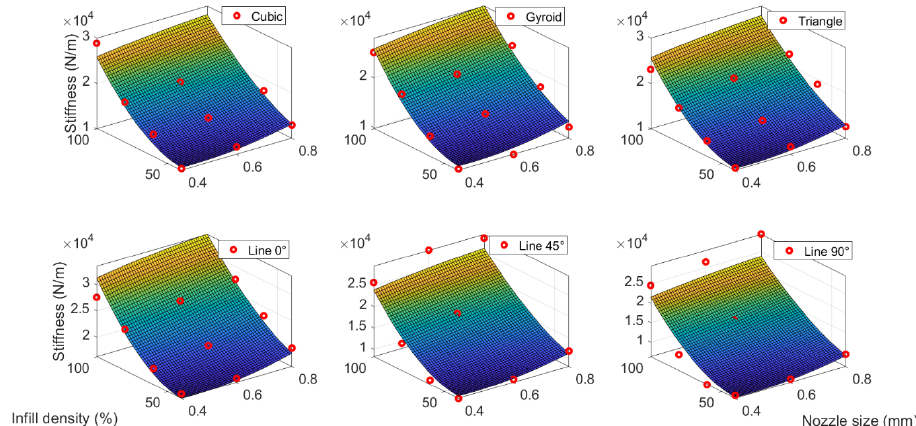
Figure 10. MLR correlation between process parameter and stiffness for different patterns.